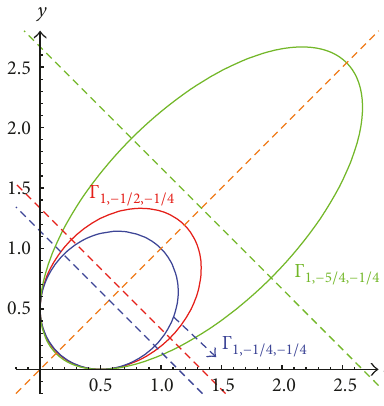
Figure 17: The Γ 1,𝜌,−1/4 , where −2 < 𝜌 < 0 .